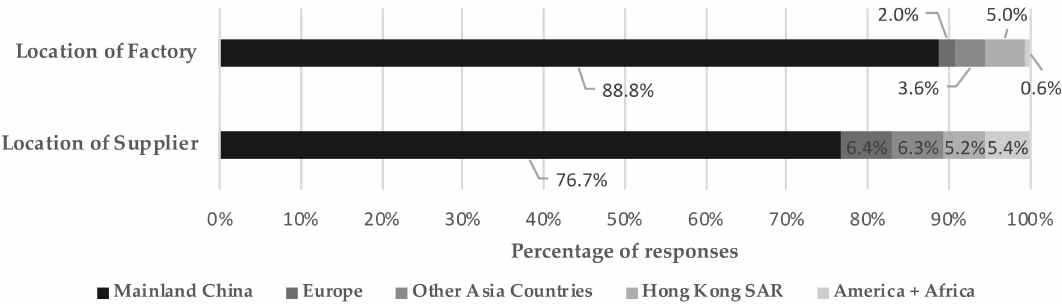
Figure 5. Location of supplier / factory of the stone block for private building projects in HK ( n =